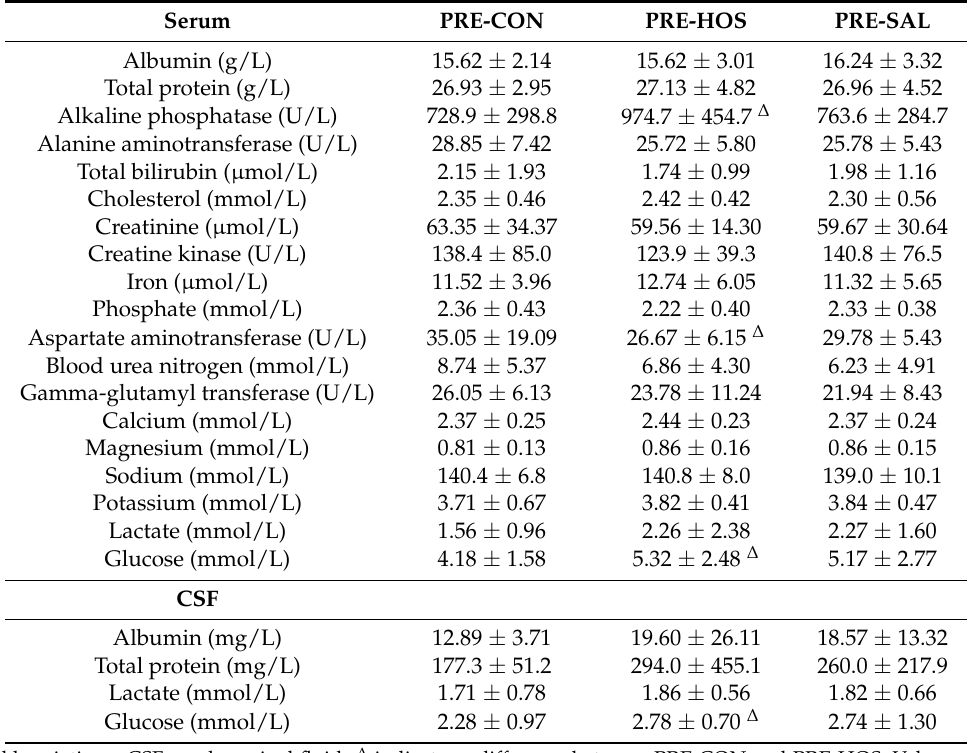
Table 1. Serum and CSF biochemistry measured at day 19 in preterm pigs (Experiment 1). Serum